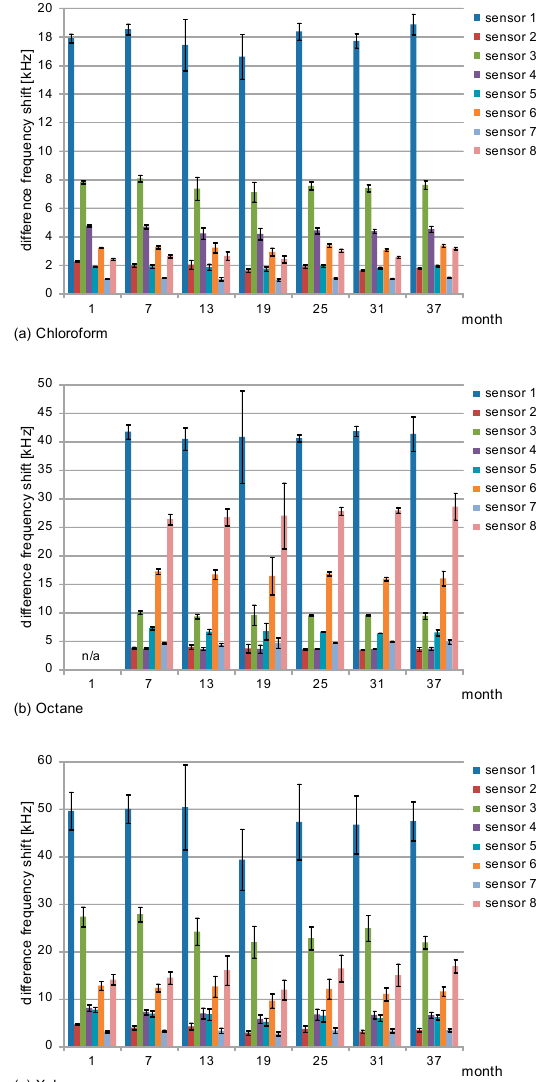
Figure 4. Difference frequency shifts obtained with the STW sensor array. Samples were ( a ) chloroform, 11.6 ppmv; ( b ) octane, 11.5 ppmv; ( c ) xylene, 4.5 ppmv. Measurements were performed in triplicate every six months for a period of three years with the exception of octane, which was included in the study half a year later. Columns represent the means; error bars represent the standard deviations of the measurements ( n = 3).